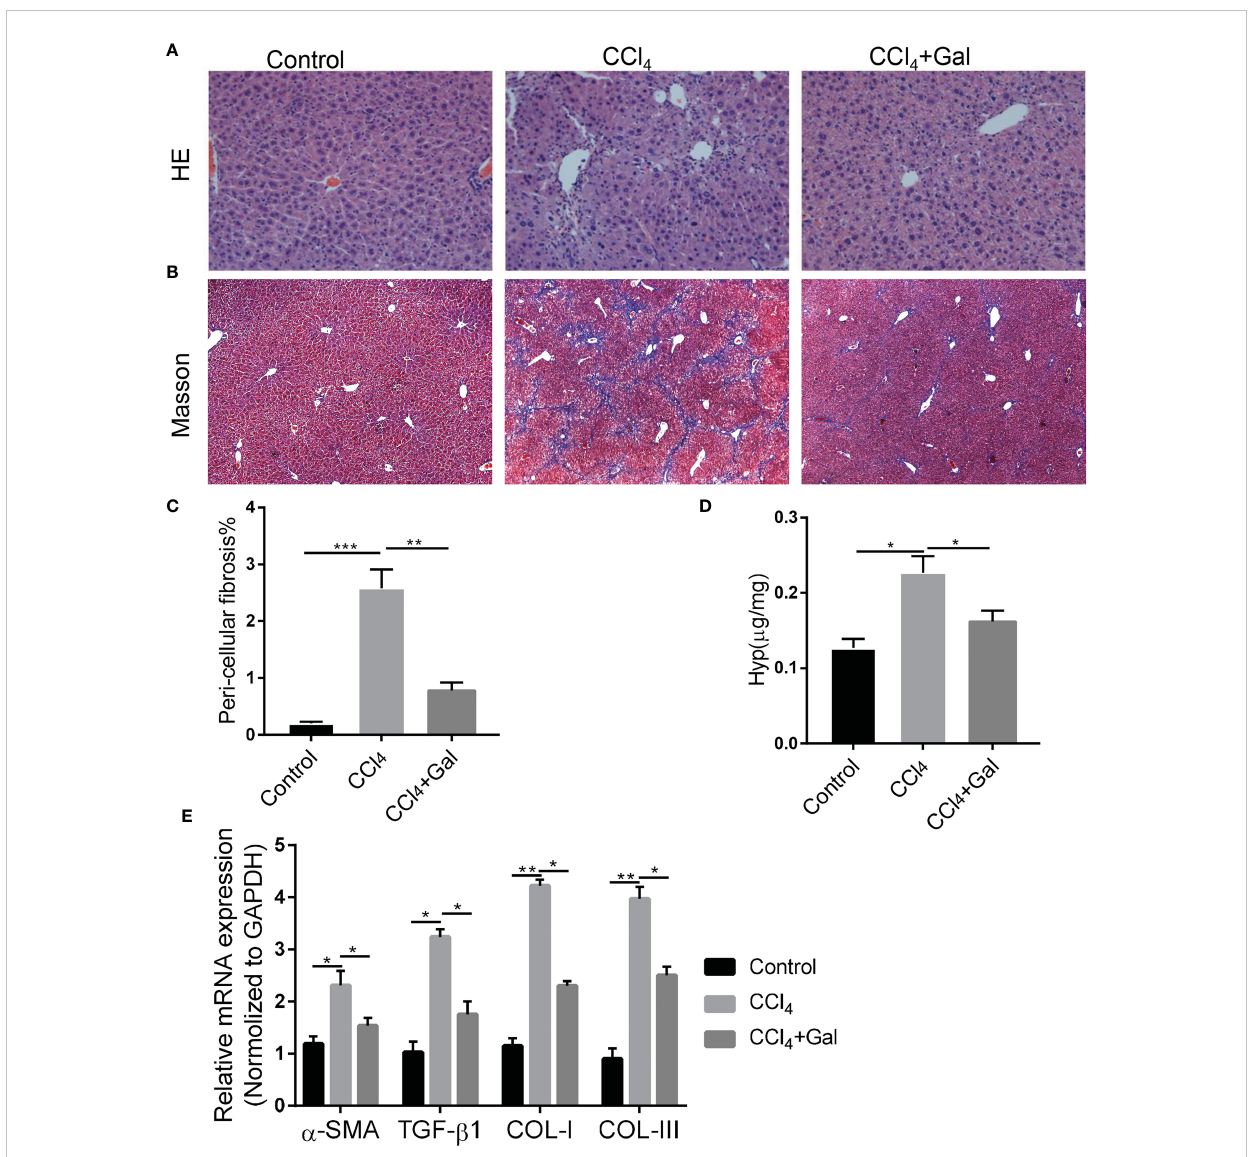
FIGURE 3 Galanin improves fi brosis induced by CCl 4 . (A, B) Representative images of liver sections stained with HE and Masson. (C) Histological quanti fi cation of liver fi brosis. **, p < 0.01. (D) Hydroxyproline content in liver in each group. *, p < 0.05. (E) Liver gene expressions of a -SMA, TGF- b 1, COL-I and COL-III in each group. *, p < 0.05, **, p < 0.01. a -SMA, Alpha smooth muscle actin; TGF- b 1, Transforming growth factor beta1; COL-I, Type I collagen; COL-III, Type III collagen; GAL,